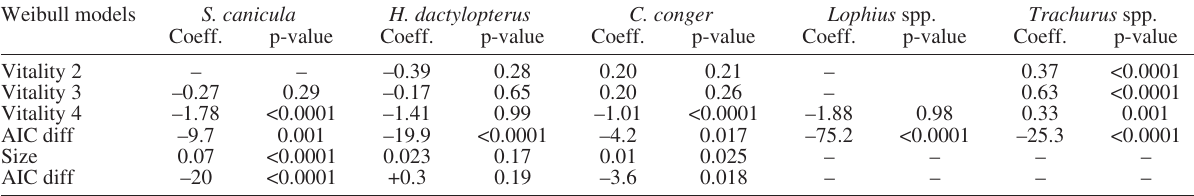
Table 4. – Coefficients and p-values from Weibull models for Scyliorhinus canicula , Helicolenus dactylopterus , Conger conger , Lophius spp. and Trachurus spp. with vitality and size as possible explanatory variables for time-to-mortality. “Coeff.”, coefficient estimates for the rela- tionship between vitality category and time-to-mortality; if positive, vitality is directly correlated with TTM; if negative, vitality is inversely correlated with TTM. “AIC diff”, difference in AIC values in comparison with the base model (without covariates). Significance level α =0.05.